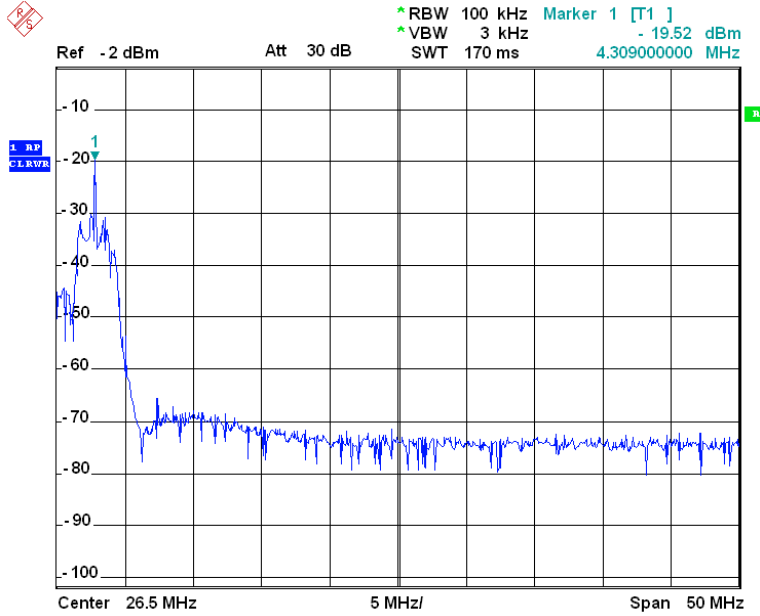
Figure 9. Typical frequency response of a RF-IF receiver. The test receiver has been driven with a CW input of −130 dBm at f = 1,575.42 MHz. The output is a tone with a GPS-L1 −19.52 dBm at f = 4.309 MHz. The rejected-band has a >40 dB of attenuation with IF respect to the